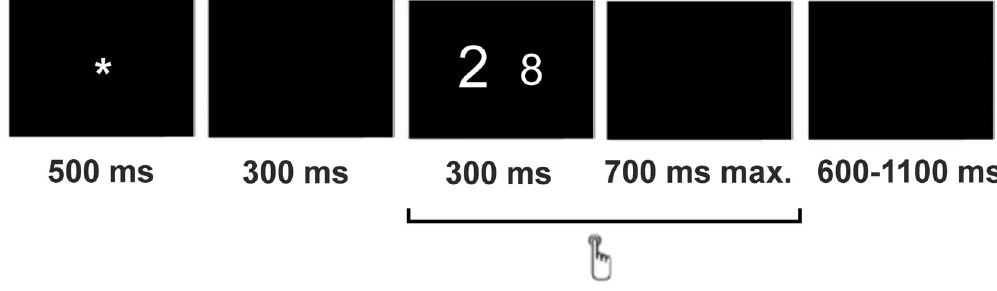
Figure 1. Structure and timing of a trial of the numerical Stroop task using an incongruent stimulus.